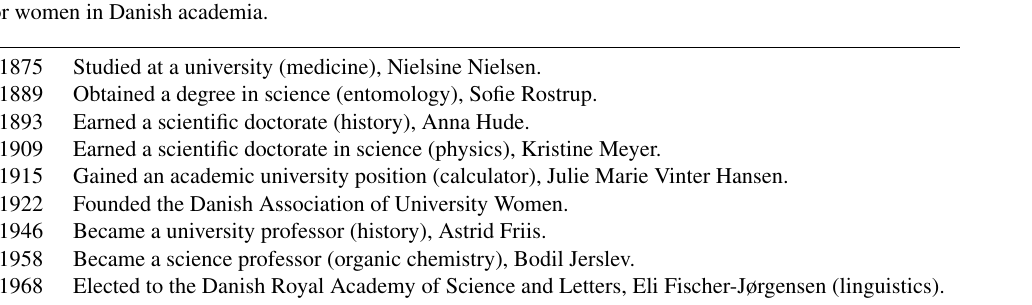
Table 2. Firsts for women in Danish academia.